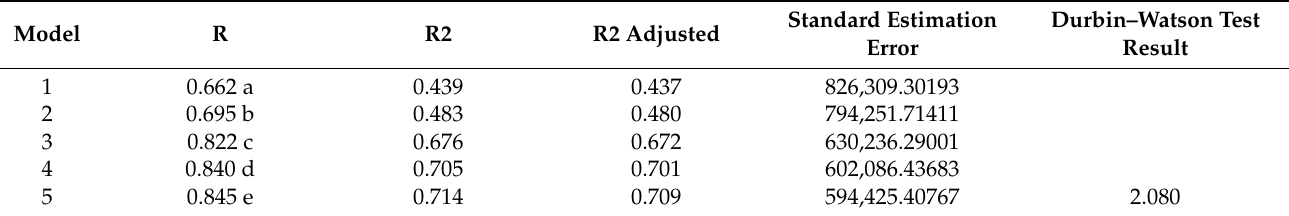
Table 4. Summary of the resulting econometric model.